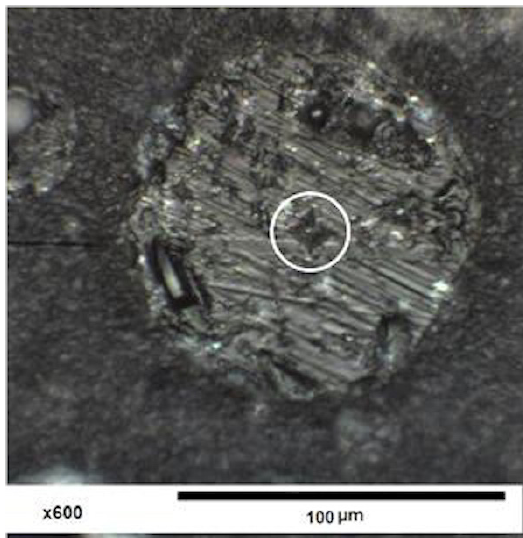
Figure 4. Cross-section of coal ash particle with Vickers microhardness penetration identification.